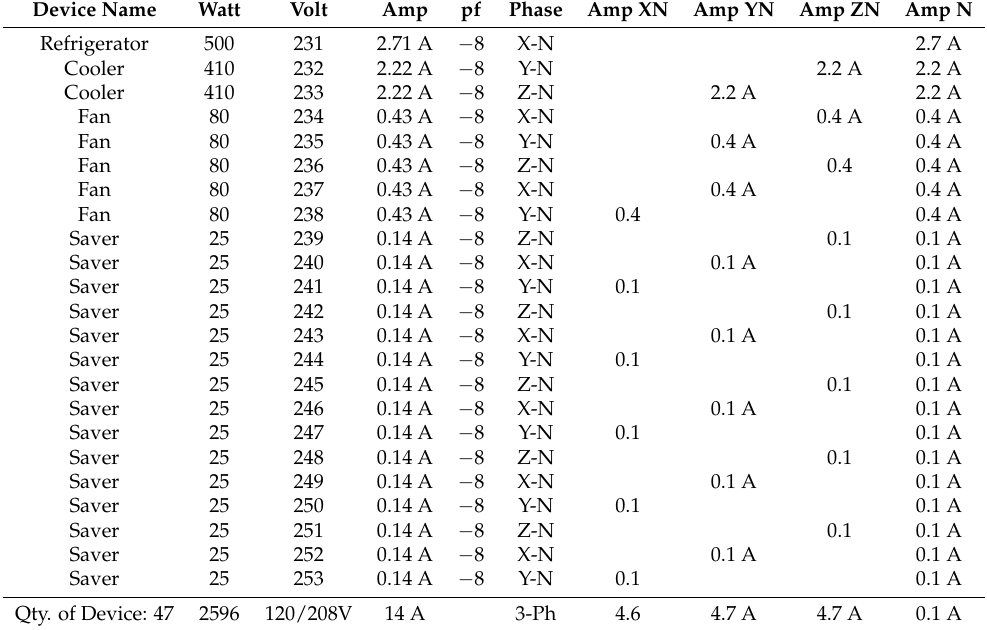
Table 16. Staff Hostel proposed load